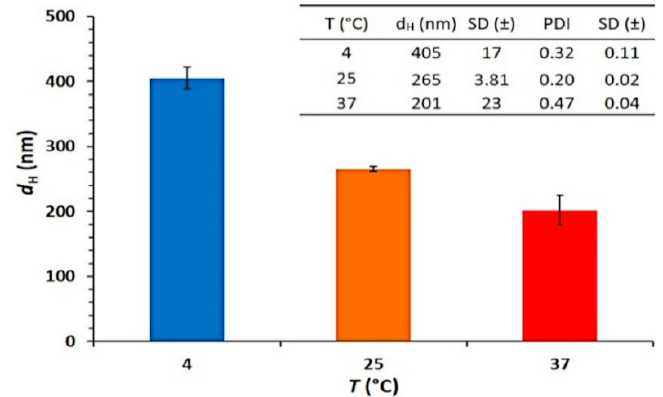
Figure 2. Average (SD±) dH (nm) of nanoMIPs batch 2 obtained by DLS analysis carried out at different temperatures (4 °C, 25 °C, 37 °C). The inset table reports the average dH (SD±) and the PDI (SD±) obtained at each temperature (n = 10).